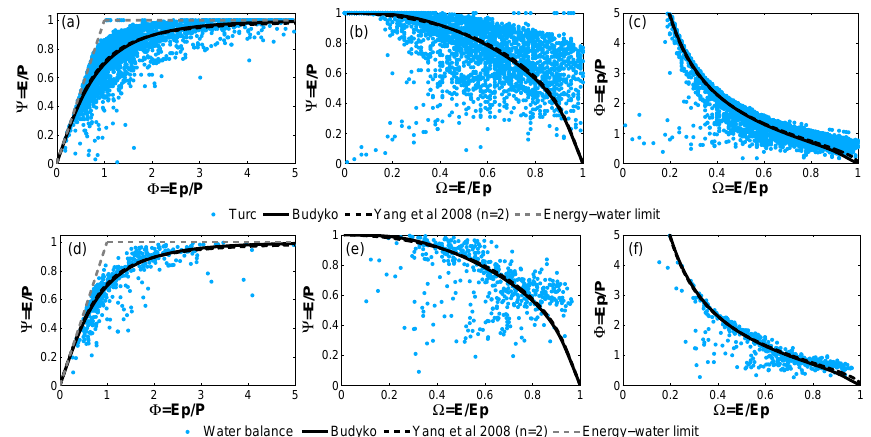
Figure 4. Bi-dimensional projections of the 3-D space for the FAO agro-climatic stations (a–c) and for catchments in the US and China (d–f) .